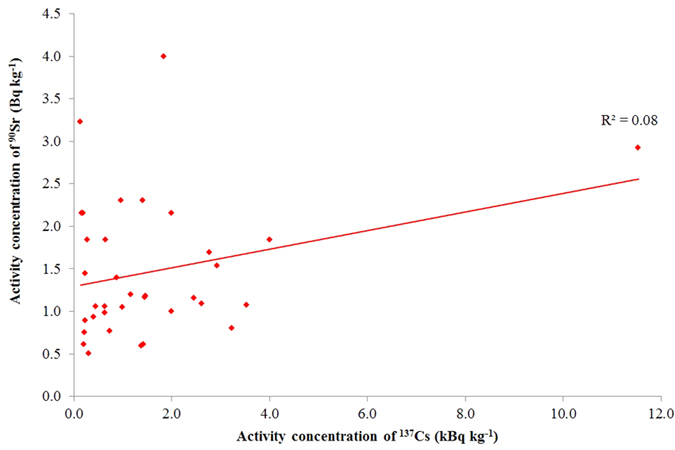
Correlation between 90Sr and 137Cs activity concentration in Fukushima soil samples collected in 2011 where the presence of 89Sr was not confirmed (n = 35).